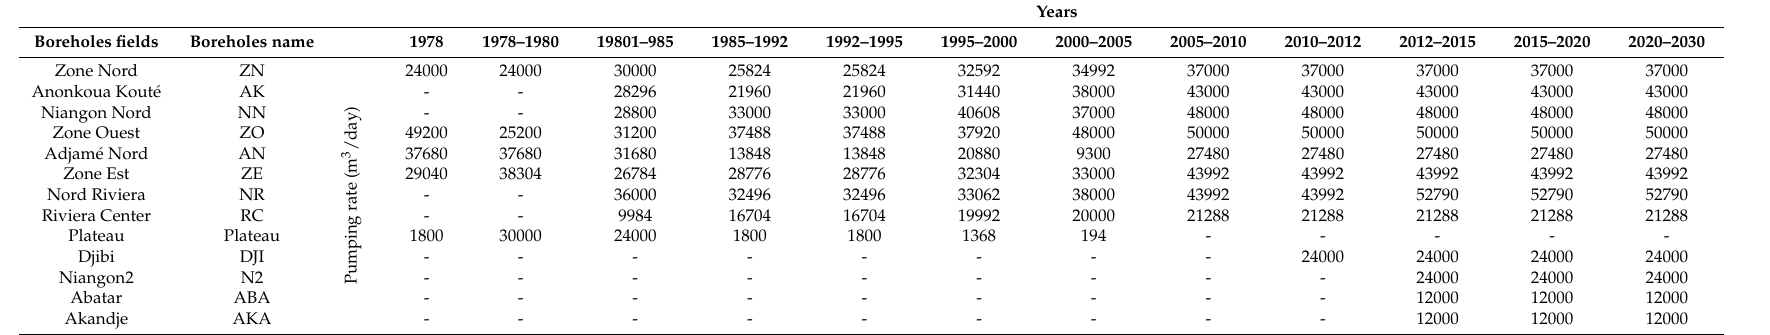
Table A3. Pumping rates (m 3 /day) from 1978 to